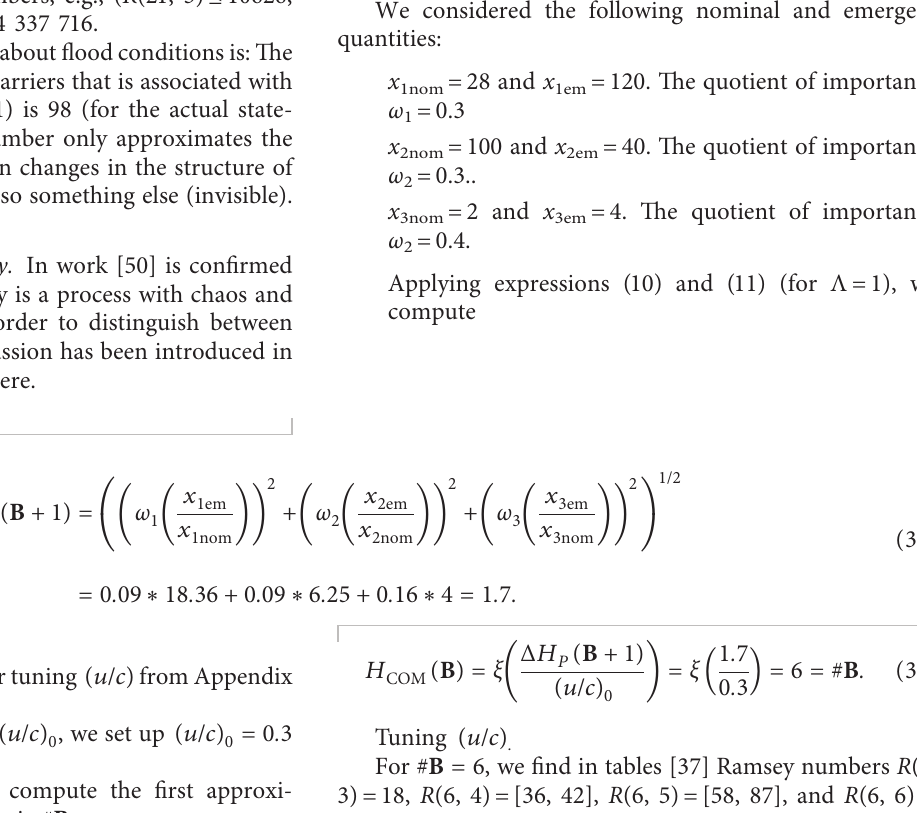
where it is allowed to use only one road strip) in 10 km of the